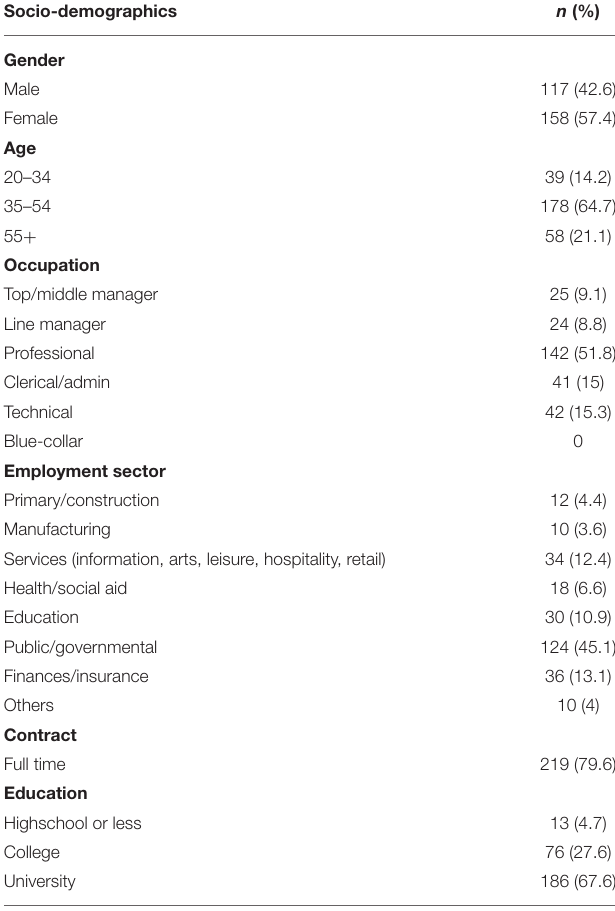
TABLE 1 | Description of the sample ( n = 275, unweighted, at